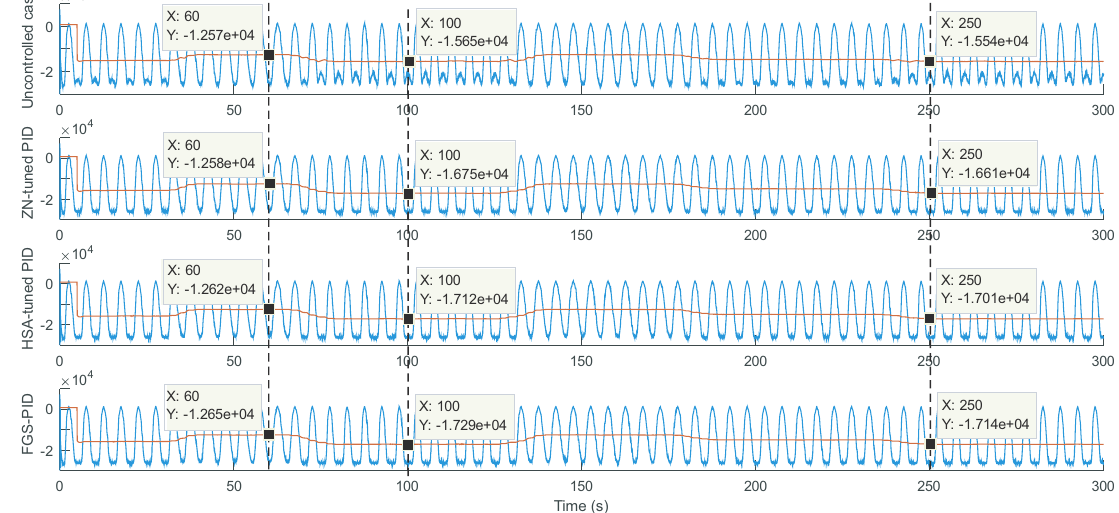
Figure 24. Generated power with different control methodologies in irregular